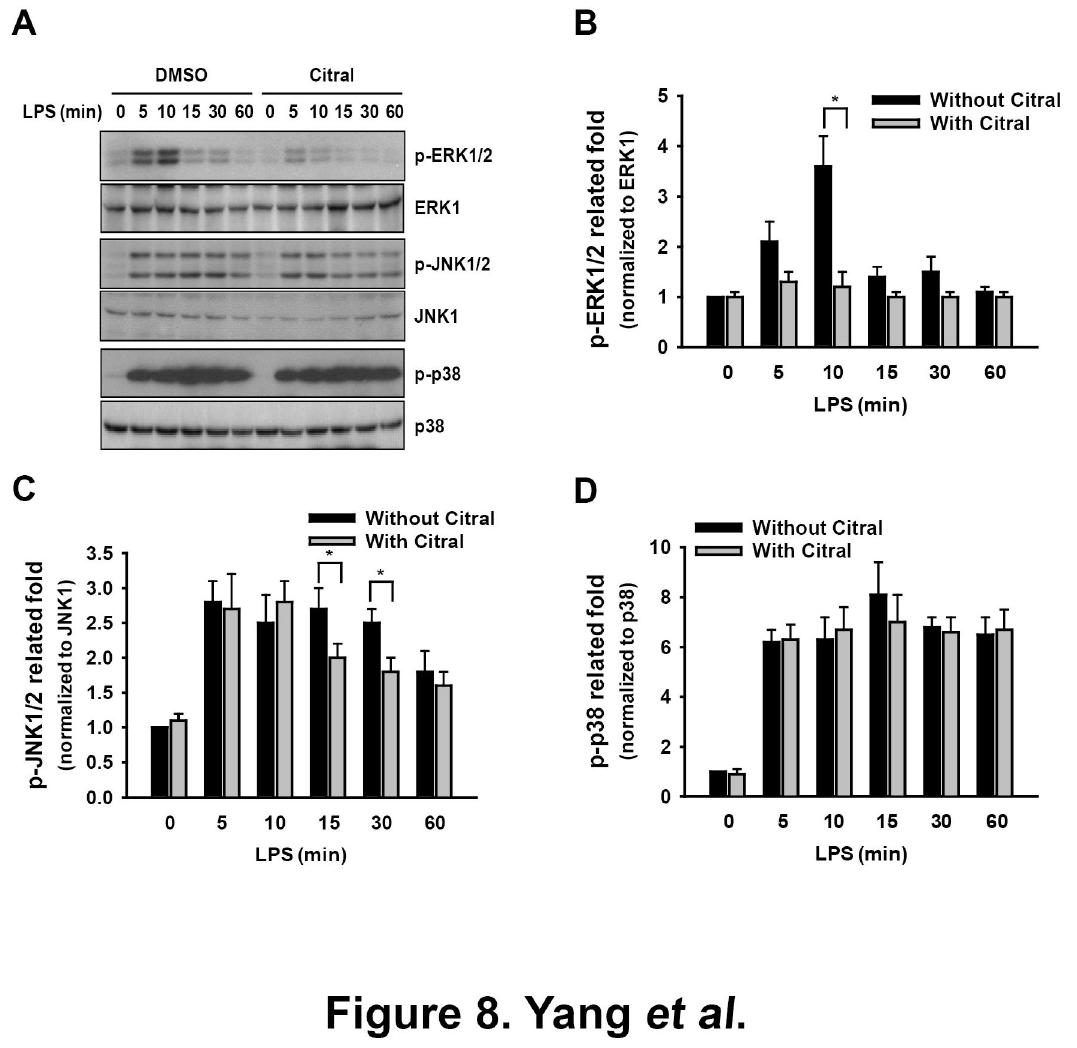
Figure 8. In vitro MAPK phosphorylation. (A) RAW 264.7 macrophages were incubated for 30 min with or without 10 µg/ml Citral, then for 0-60 min with or without addition of 1 µg/ml of LPS, then the phosphorylation levels of ERK1/2, JNK1/2, and p38 were measured by Western blotting. In B-D, the results in the phosphorylation levels of ERK1/2 (B), JNK1/2 (C), and p38 (D) are representative of those obtained in three separate experiments and the histogram shows the results for all three experiments expressed as the mean ± SD. * p < 0.05 compared to the corresponding group without